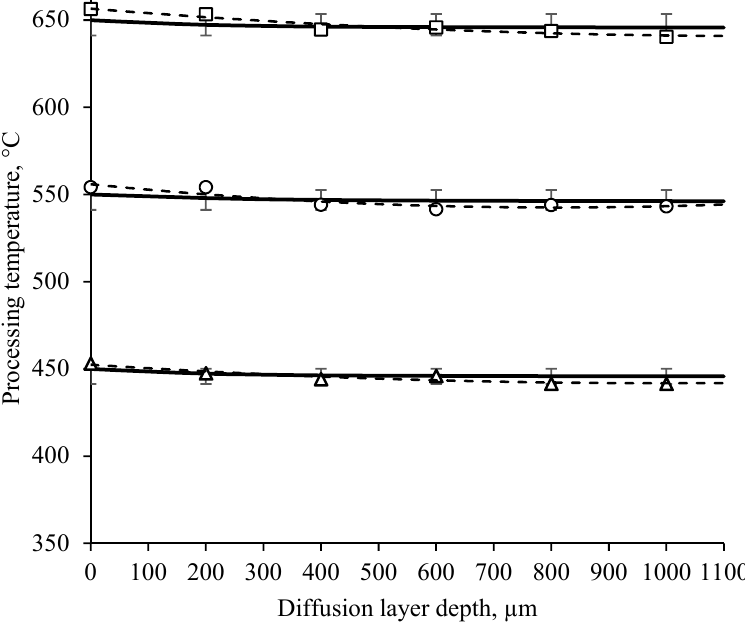
Figure 1. Temperature distribution over the depth of the diffusion layer at different processing temperatures.